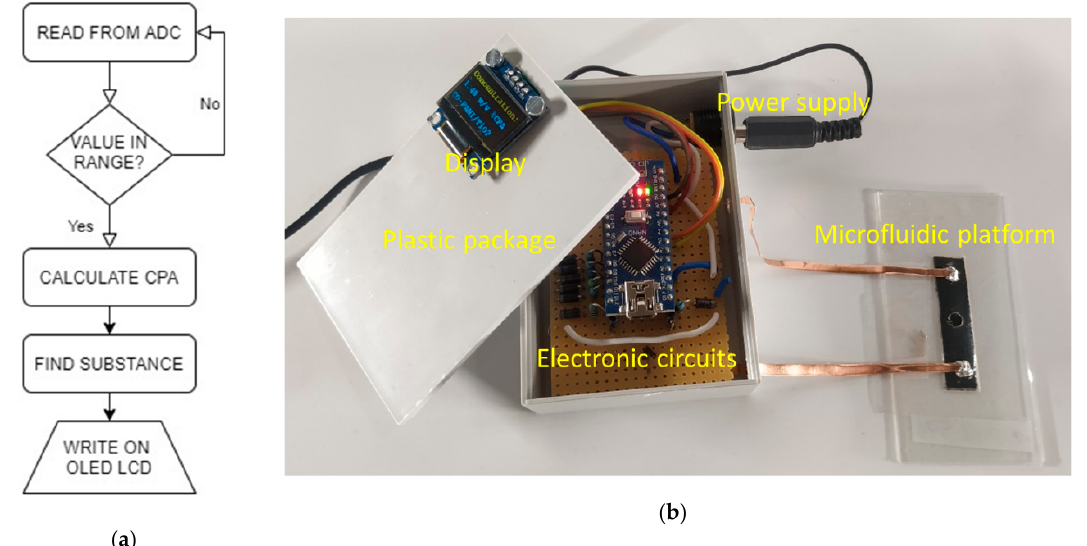
Figure 6. ( a ) A block diagram of the electronic circuit for data acquisition from the microfluidic platform, processing and displaying measured data (ADC - analog-to-digital converter); ( b ) The electronic device for displaying the measured concentration of CPA.